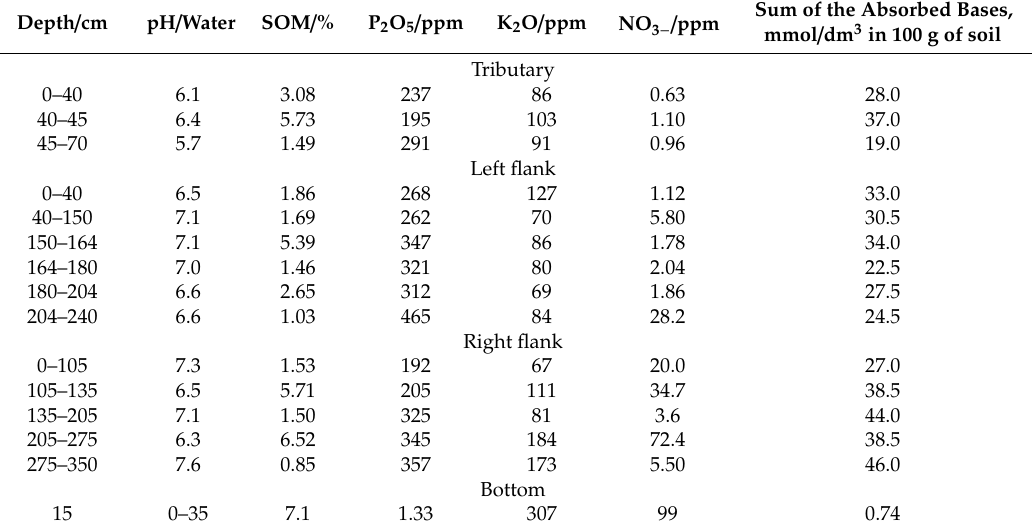
Table 2. Some chemical properties of soil in the Bulanka